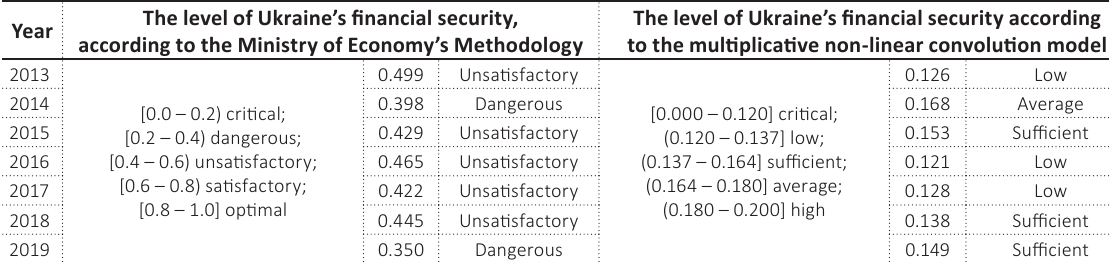
Table 10. Comparison of the results of assessing Ukraine’s financial security using two methodologies The level of Ukraine’s financial security